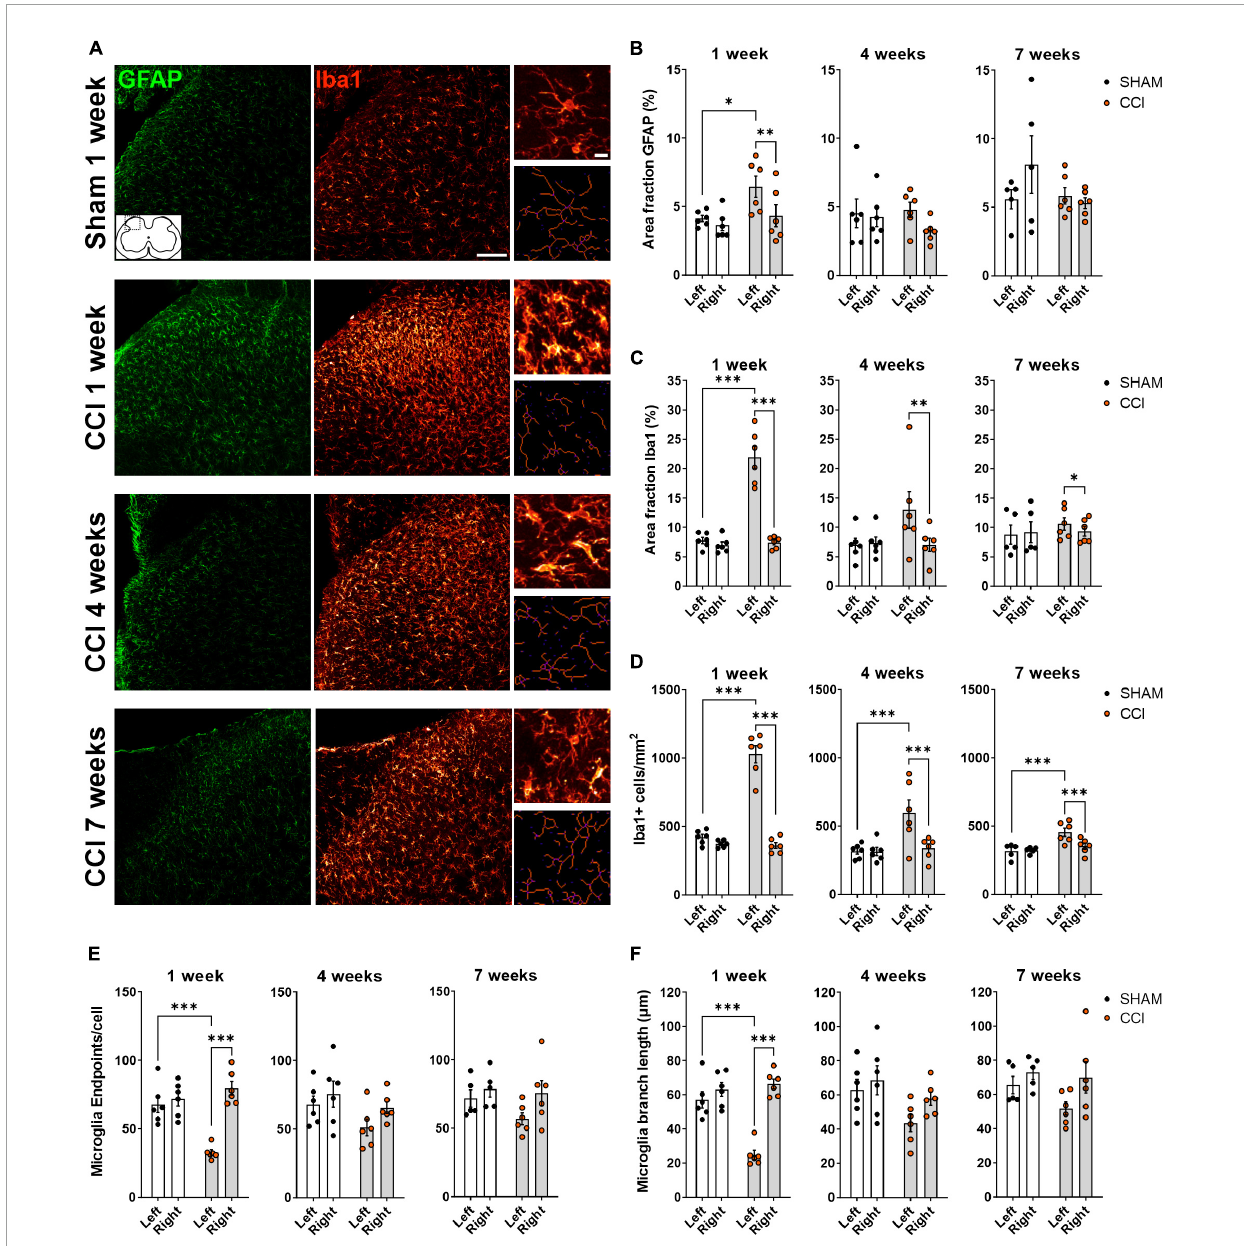
FIGURE2 CCI induces glial activation in ipsilateral spinal dorsal horn that partially subside over time. (A) Representative images of the left spinal dorsal horn, ipsilateral to CCI or sham surgery, showing immunohistochemical labeling of the astrocytic marker GFAP (green) and the microglial marker Iba1 (red). Insets on the right show high-magnification images of microglial cells (top), and the corresponding skeletons (bottom) used for quantitative evaluation of microglia morphology. Scale bars: 100 µ m for overview images, 10 µ m for insets. (B,C) Immunofluorescence density (Area fraction) of GFAP (B) and Iba1 (C) at 1, 4 and 7 weeks following surgery. (D–F) Quantification of microglial cell number per mm 2 (D) and microglial morphology (E,F) revealed a strong microgliosis and a deramified phenotype of microglia, as indicated by a reduction in the number of extremities [endpoints, (E) ] and in branch length (F) . Microglial activation peaked 1 week following CCI induction, and elevated microglia density was still detected at 7 weeks. ∗ p < 0.05, ∗∗ p < 0.01, and ∗∗∗ p < 0.001, n = 6 rats per treatment, 3–4 slices per